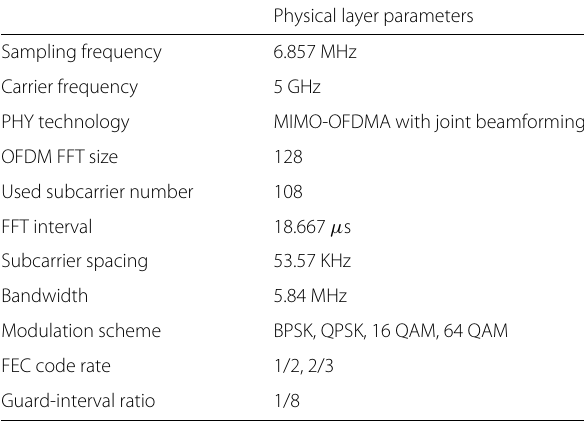
Table 1 PHY layer